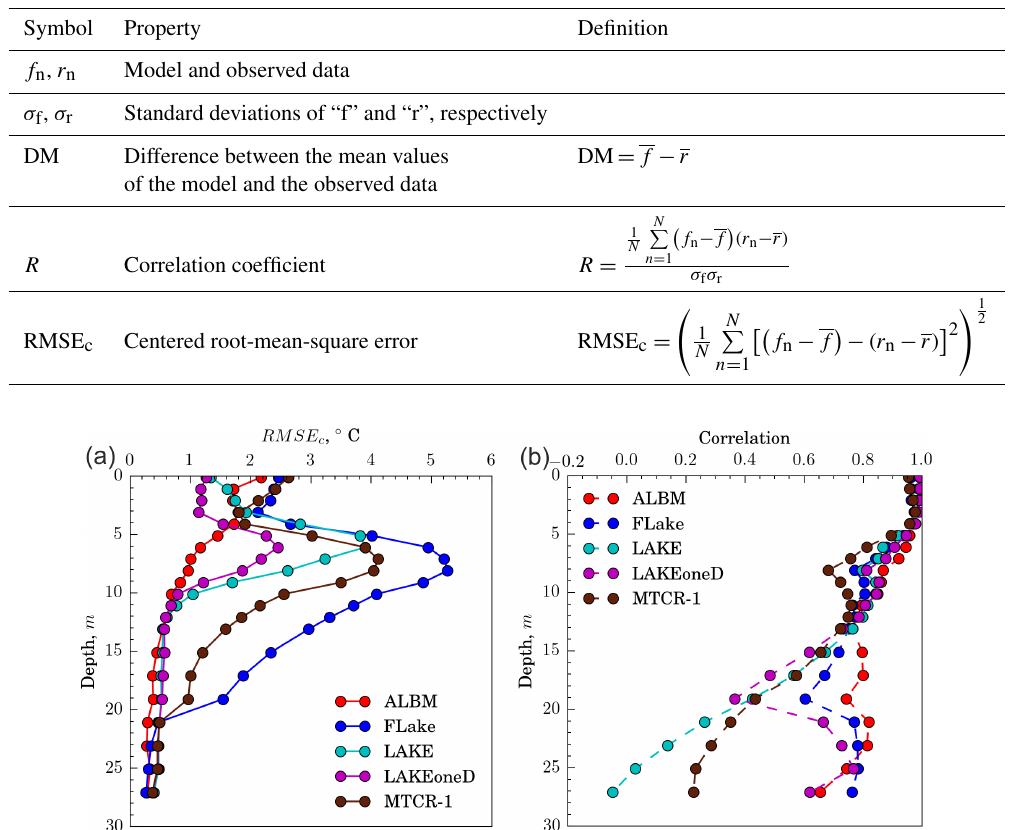
Figure 3. (a) Centered root-mean-square error of modeled temperature calculated for each individual depth; (b) the correlation coefficient between the simulated and observed temperatures at each